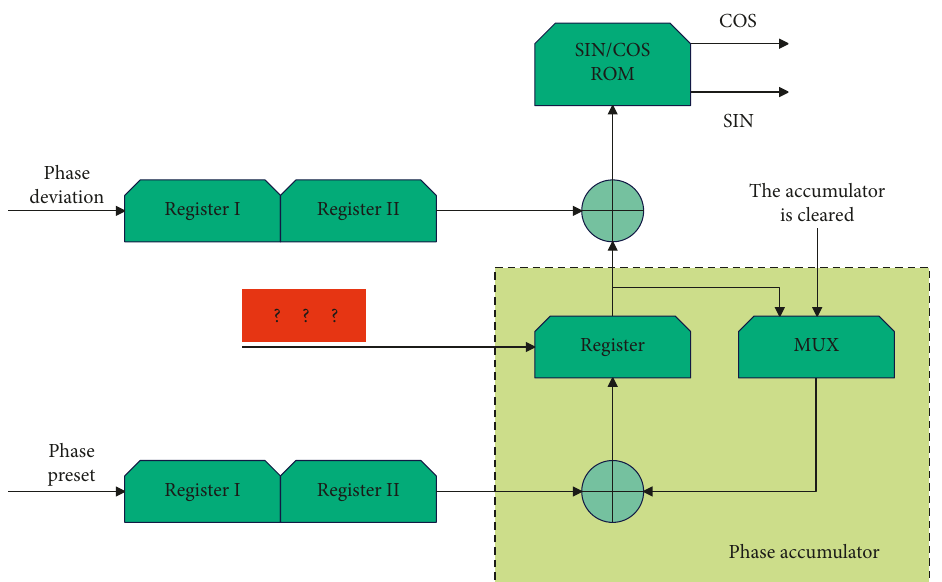
Figure 2: Numerically controlled oscillator.